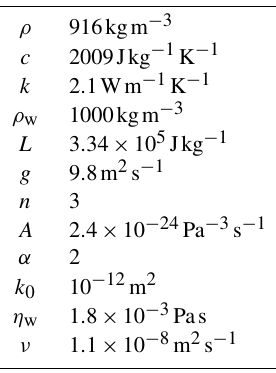
Table 1. Values of parameters used for example solutions. The value of ν is 100 times smaller than k/ρc .